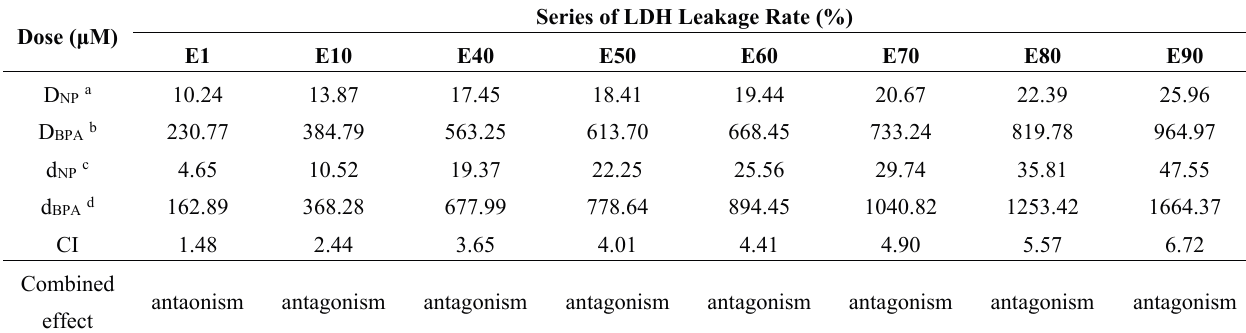
Table 5. Effect of single and combined nonylphenol (NP) and bisphenol A (BPA) on the lactate dehydrogenase (LDH) leakage rate of RWPE-1 cells and the combination index (CI) derived from the Loewe additivity (LA) model.